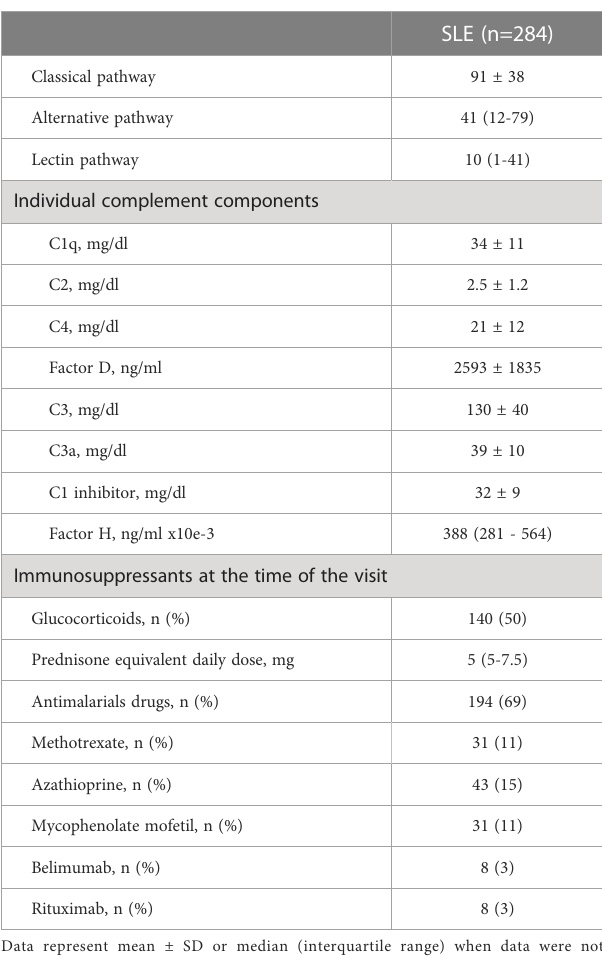
TABLE 1 Demographic and disease-related data of patients and